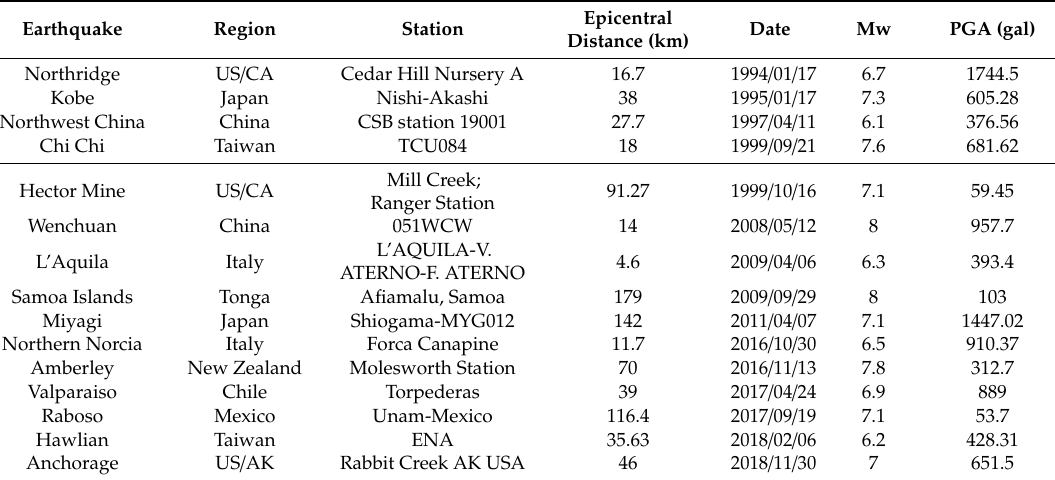
Table 4. List of the 15 ground motions of worldwide earthquake dataset.